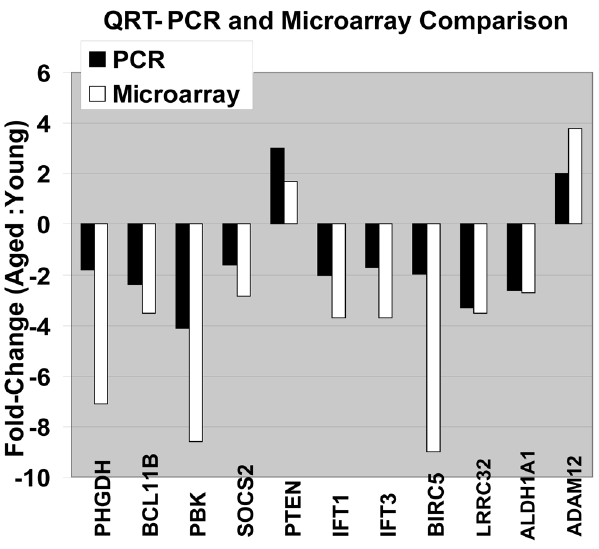
Figure 2. Validation of microarray data with real-time quanti- tative RT-PCR. qRT-PCR validation. Black bars represent microarray hybridizations, while white bars represent values from qRT-PCR. Ratio of expression for each gene (aged group to young group) is shown as fold change. The Pearson correlation coefficient between the qRT-PCR and microarray data was 0.64.